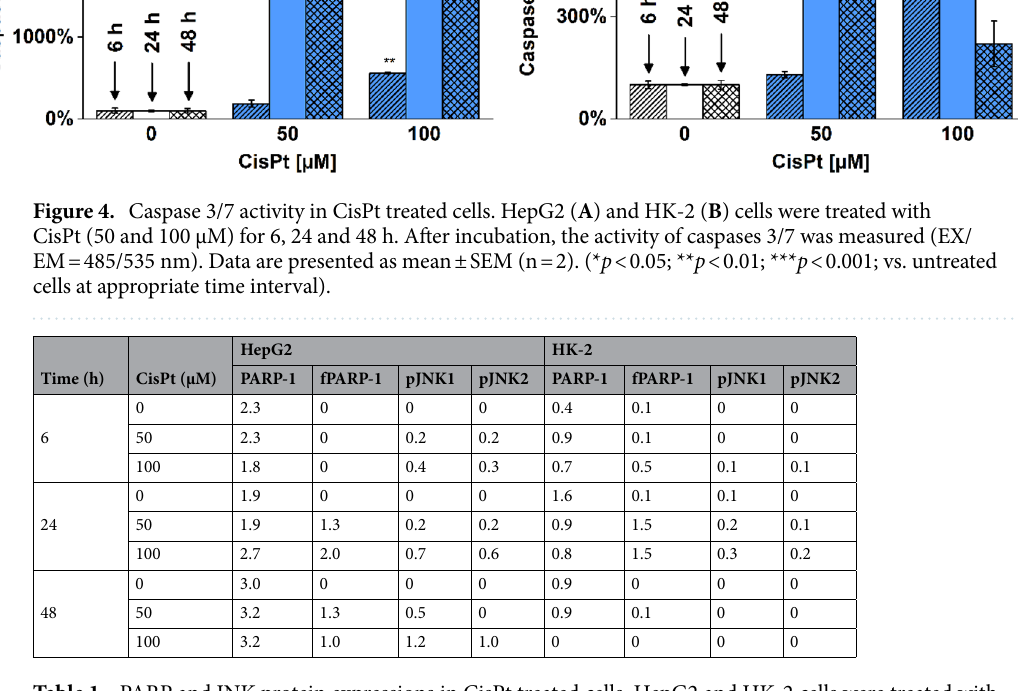
Table 1. PARP and JNK protein expressions in CisPt treated cells. HepG2 and HK-2 cells were treated with CisPt (50 and 100 µM) for 6, 24 and 48 h. After incubation, the protein expression of PARP-1, fPARP-1, pJNK1 and pJNK2 was analyzed using capillary Western immunoassay. The results were expressed as a ratio: areaofthepeakofinterest areaofthepeakof β - actin